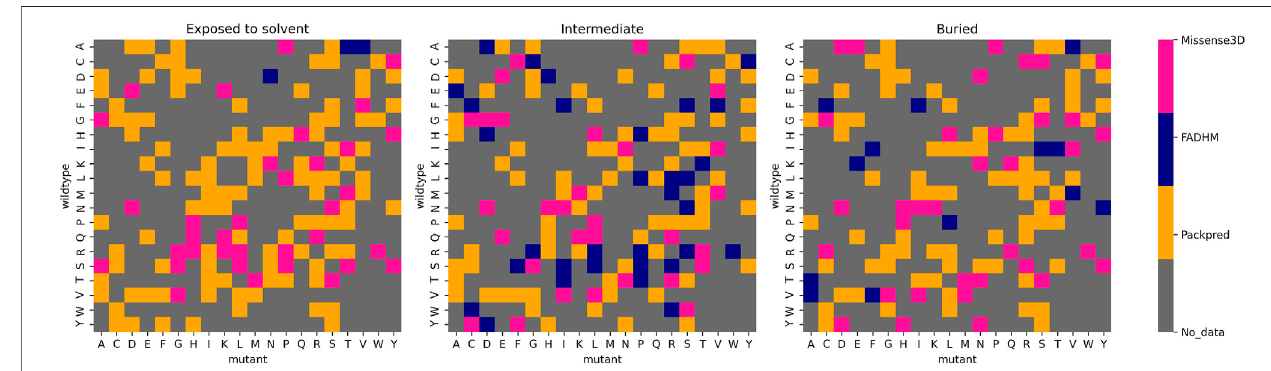
FIGURE 3 | Best performing methods for each wild-type mutant amino acid pair at different depth